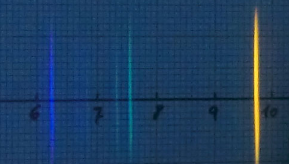
FIG. 1. English version of the questionnaire used to investigate students ’ ideas on absorption and emission spectra. Q1S-absorption spectra, prediction on absorption phenomena, Q2S-emission spectra, prediction on emission spectra, and Q3S-spectra lines intensity, interpretation of spectral lines ’